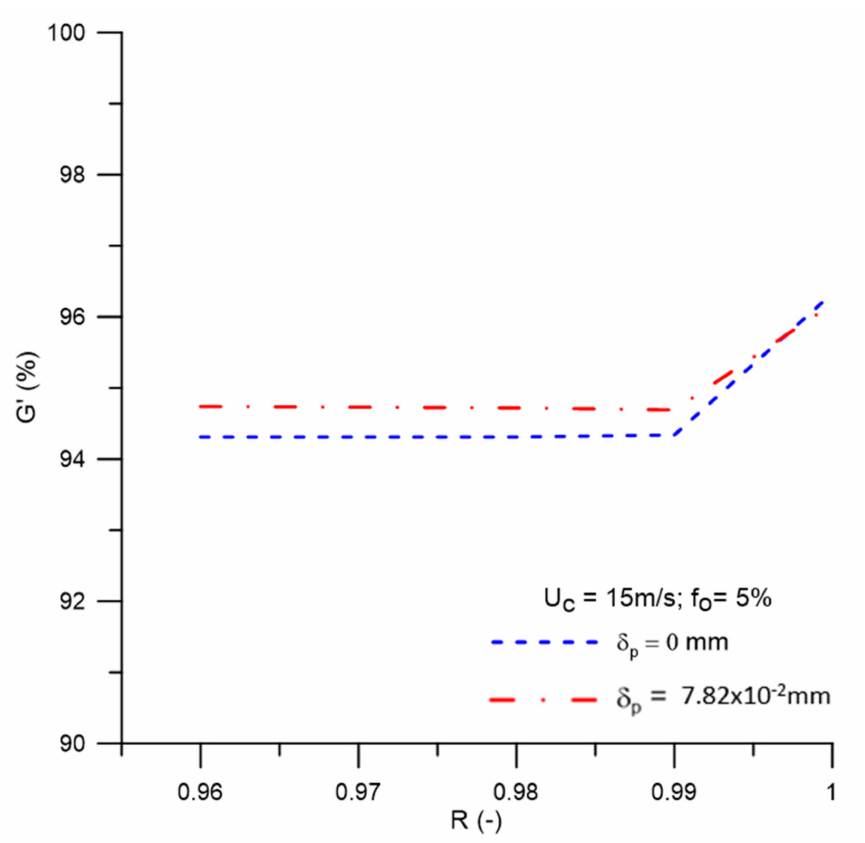
Figure 17. Reduced efficiency behavior of the hydrocyclone for different values of the membrane rejection